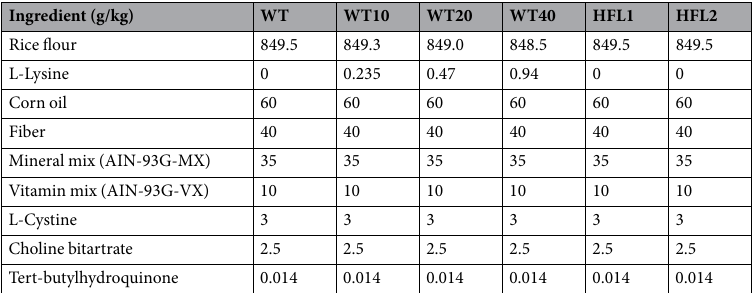
Table 1. Formulation of the experimental rice-based diets.